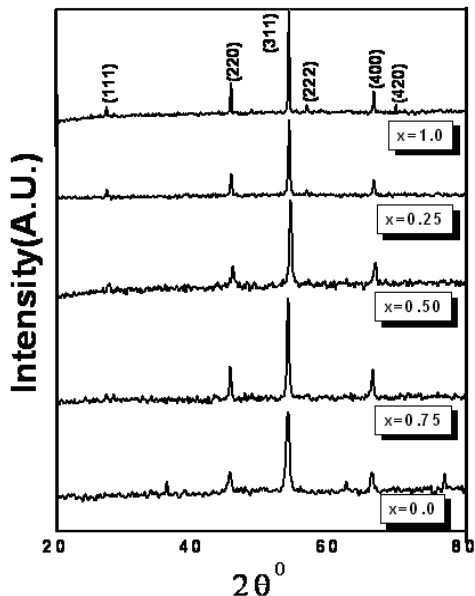
Fig. 4. XRD Patterns for the Mg